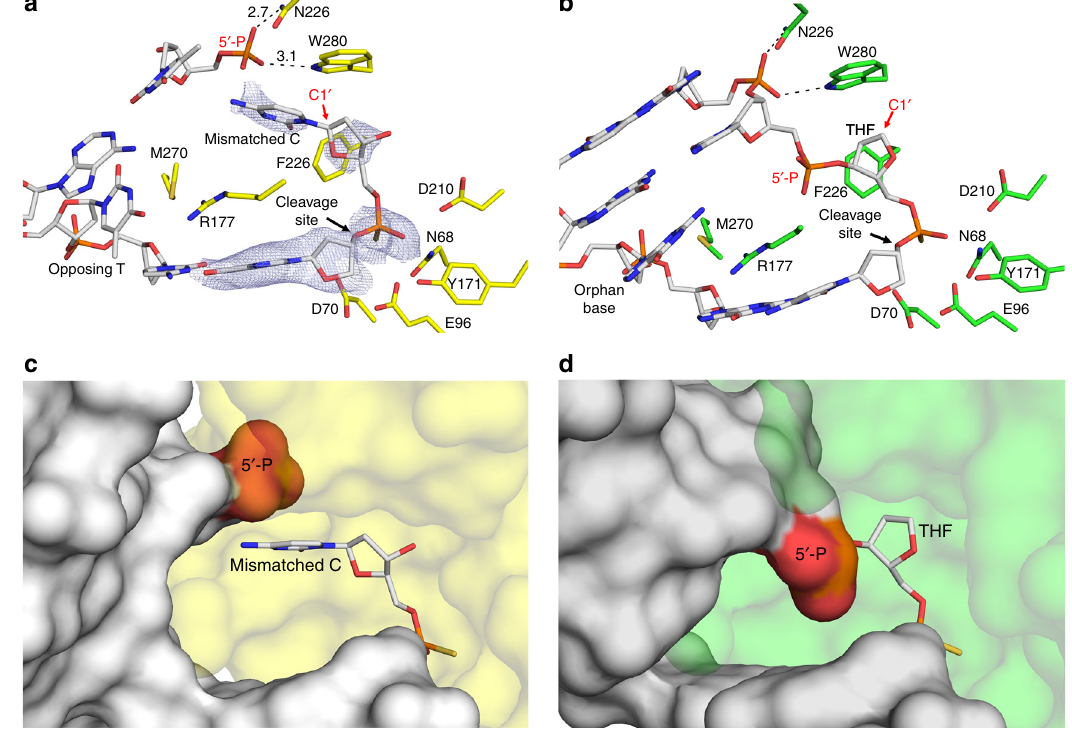
Fig. 2 The APE1 exo substrate complex. a , b Active site of APE1 a exo and b endo (PDB 5DFI) substrate complexes with key residues indicated. The C1 ʹ of the 3 ʹ mismatched base and THF are indicated by red arrows. The cleavage sites are indicated by black arrows. 2 F o – F c map density (1 σ ) for the 3 ′ mismatched and fl anking base is shown in light blue. c , d Surface representation of c exo and d endo active sites showing the varying bends of the DNA and displacement of the exo 5 ʹ -P to vacate the active site for the 3 ʹ mismatched base. The 5 ′ -P is shown as surface in red. The protein side chains are shown in yellow (exo) or green (endo) and DNA residues in